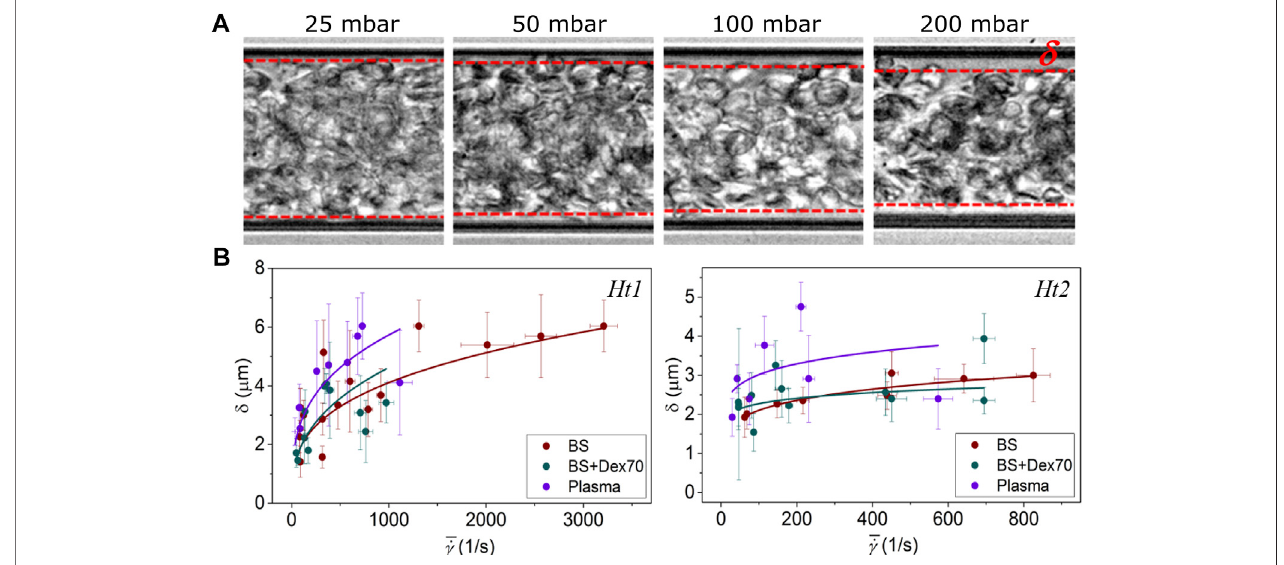
FIGURE 4 | (A) Representative pictures of the CDL thickness ( δ ); (B) , δ vs. average shear rate. A power law fi tting has been included for easier visualization of the CDL thickness